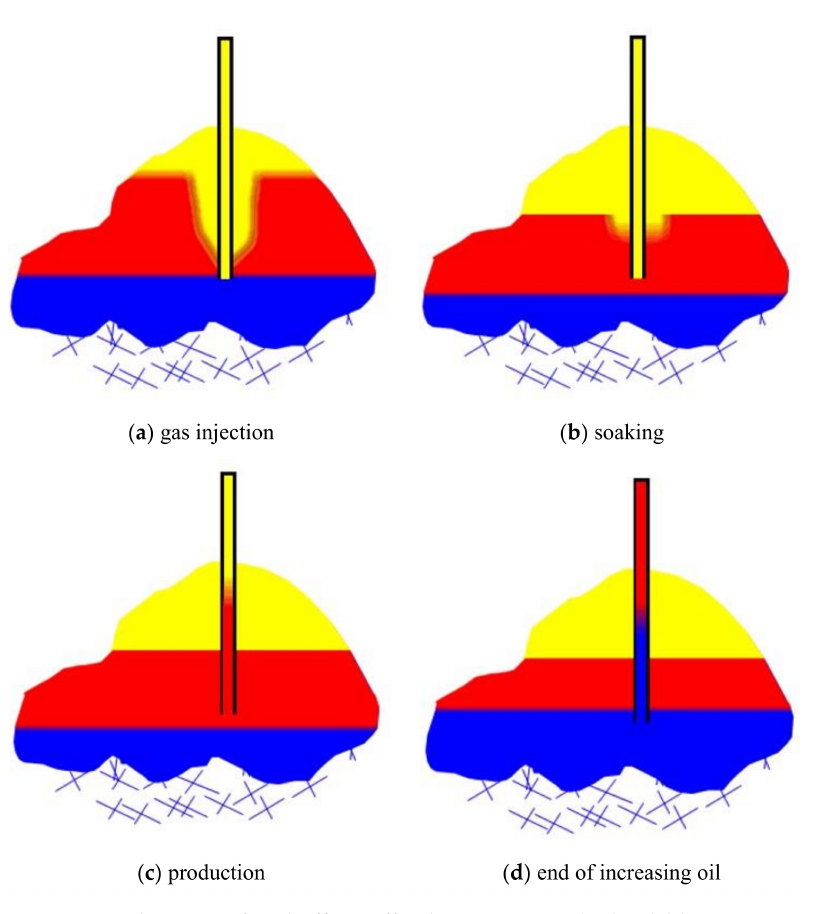
Figure 2. Mechanisms of N 2 huff-n-puff in karst reservoir (red: oil; blue: water; yellow: gas).